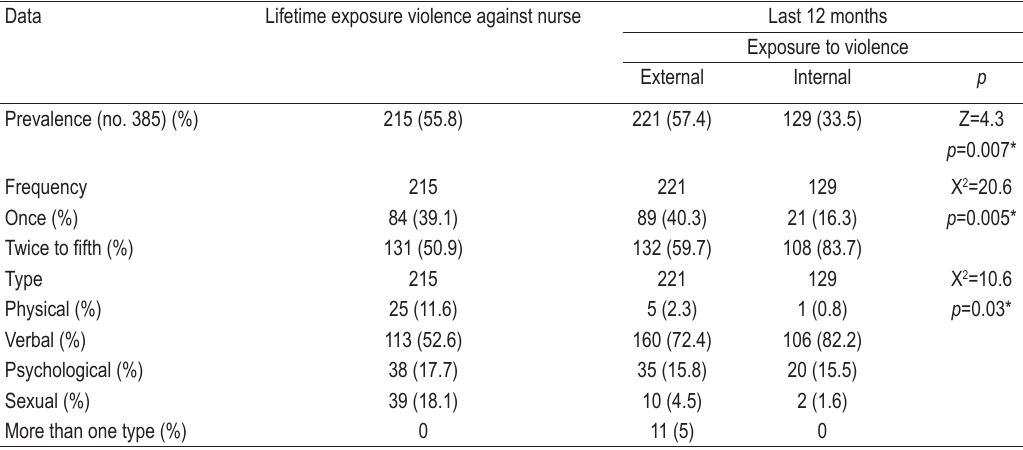
TABLE 2. Prevalence of lifetime exposure to violence prevalence, external and internal violence against nurses during the past